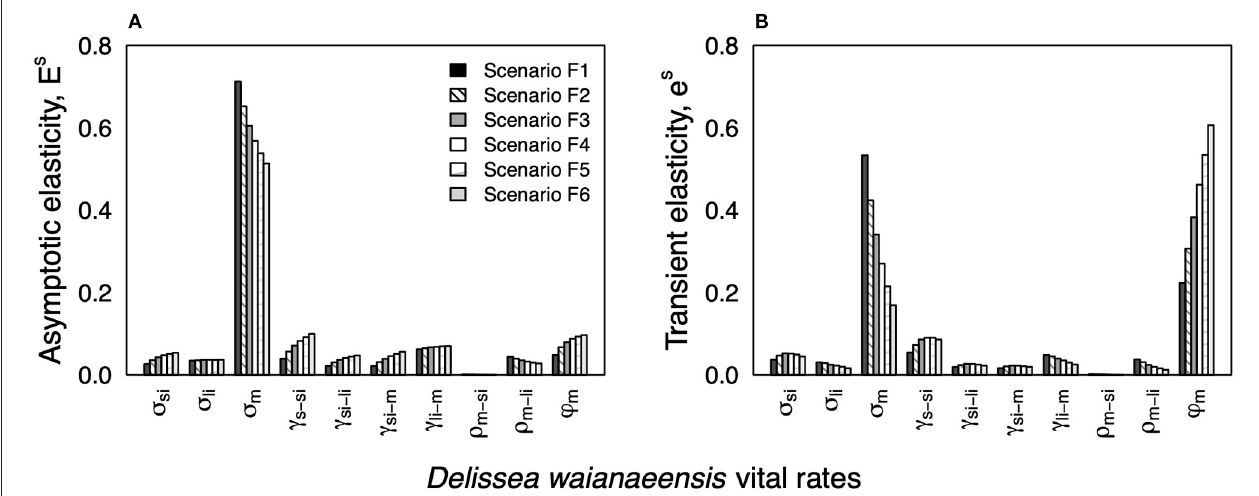
FIGURE 3 | Stochastic (A) asymptotic elasticity E s δ and (B) transient e s δ to the mean and variance. Seedling (S); small immature > 40cm (SI); large immature, > 40cm (LI); and mature signs of reproduction (M). For scenario F1 (i.e., field conditions), the probability of high recruitment years was 0.17 (i.e., once every 6 years). Elasticity values are grouped by demographic process (i.e., stasis σ , survival and growth to the next stage class γ , shrinkage ρ , and seedling recruitment ϕ m ). For scenarios F2 – F6, the probability of high recruitment increased by 0.17 for each consecutive simulation.